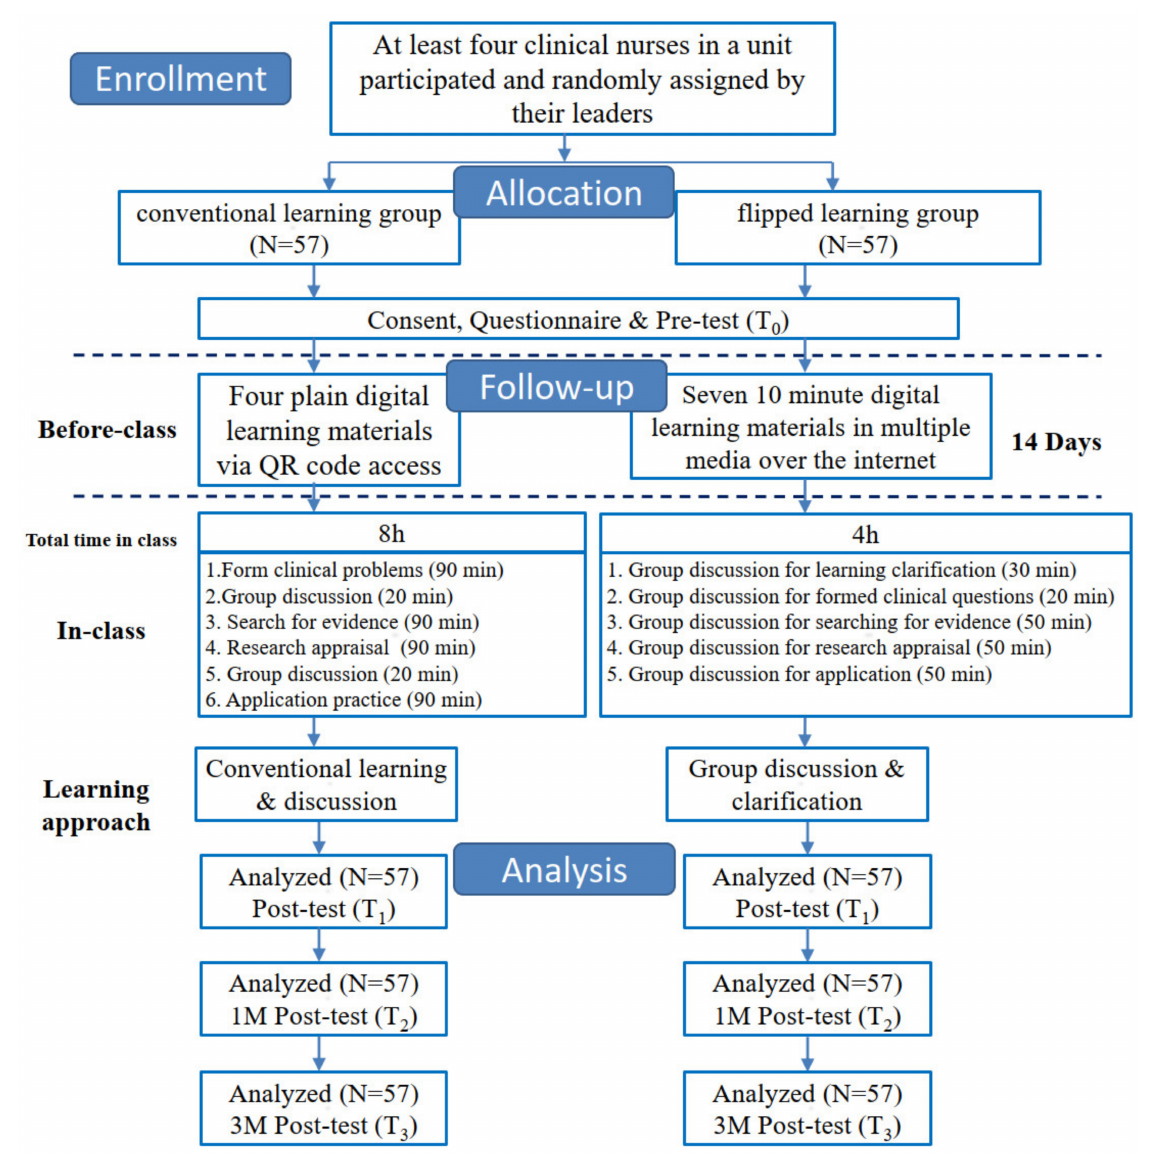
Figure 1. Experiment design for the conventional learning group and the flipped learning